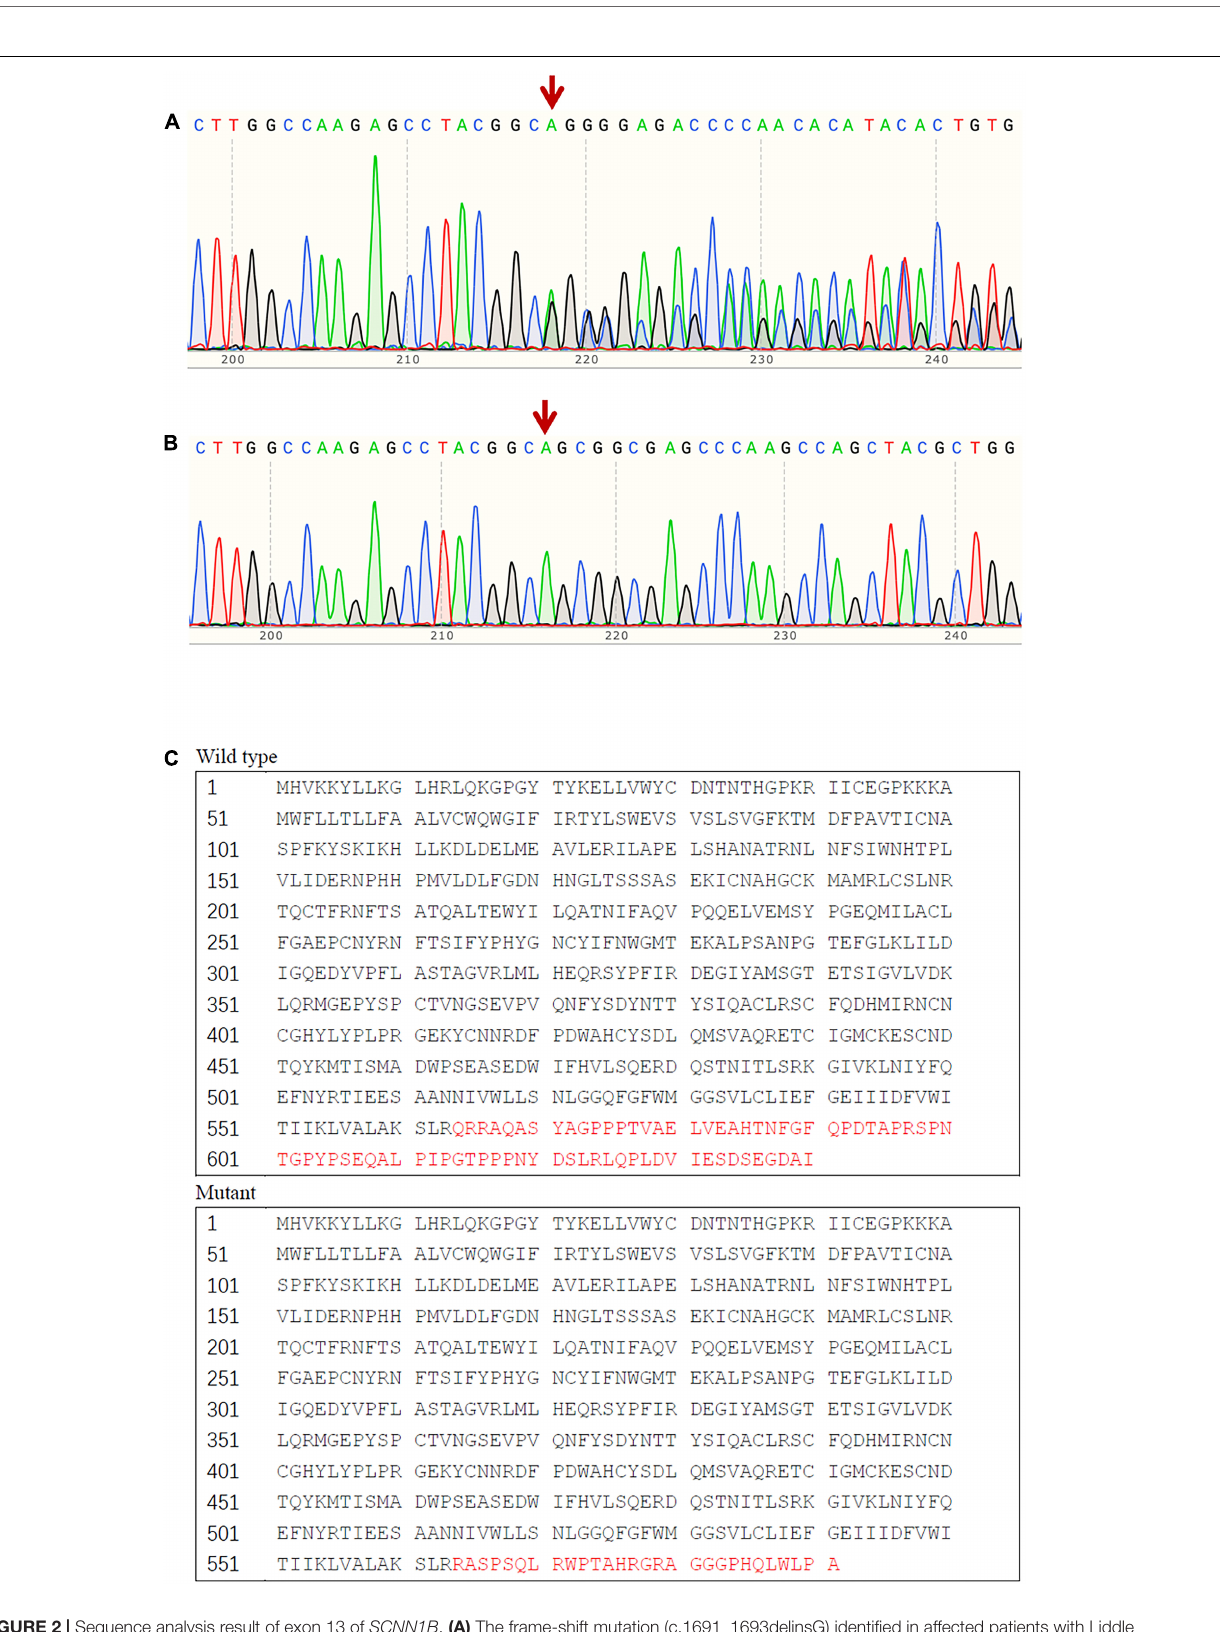
Frontiers in Cardiovascular Medicine |